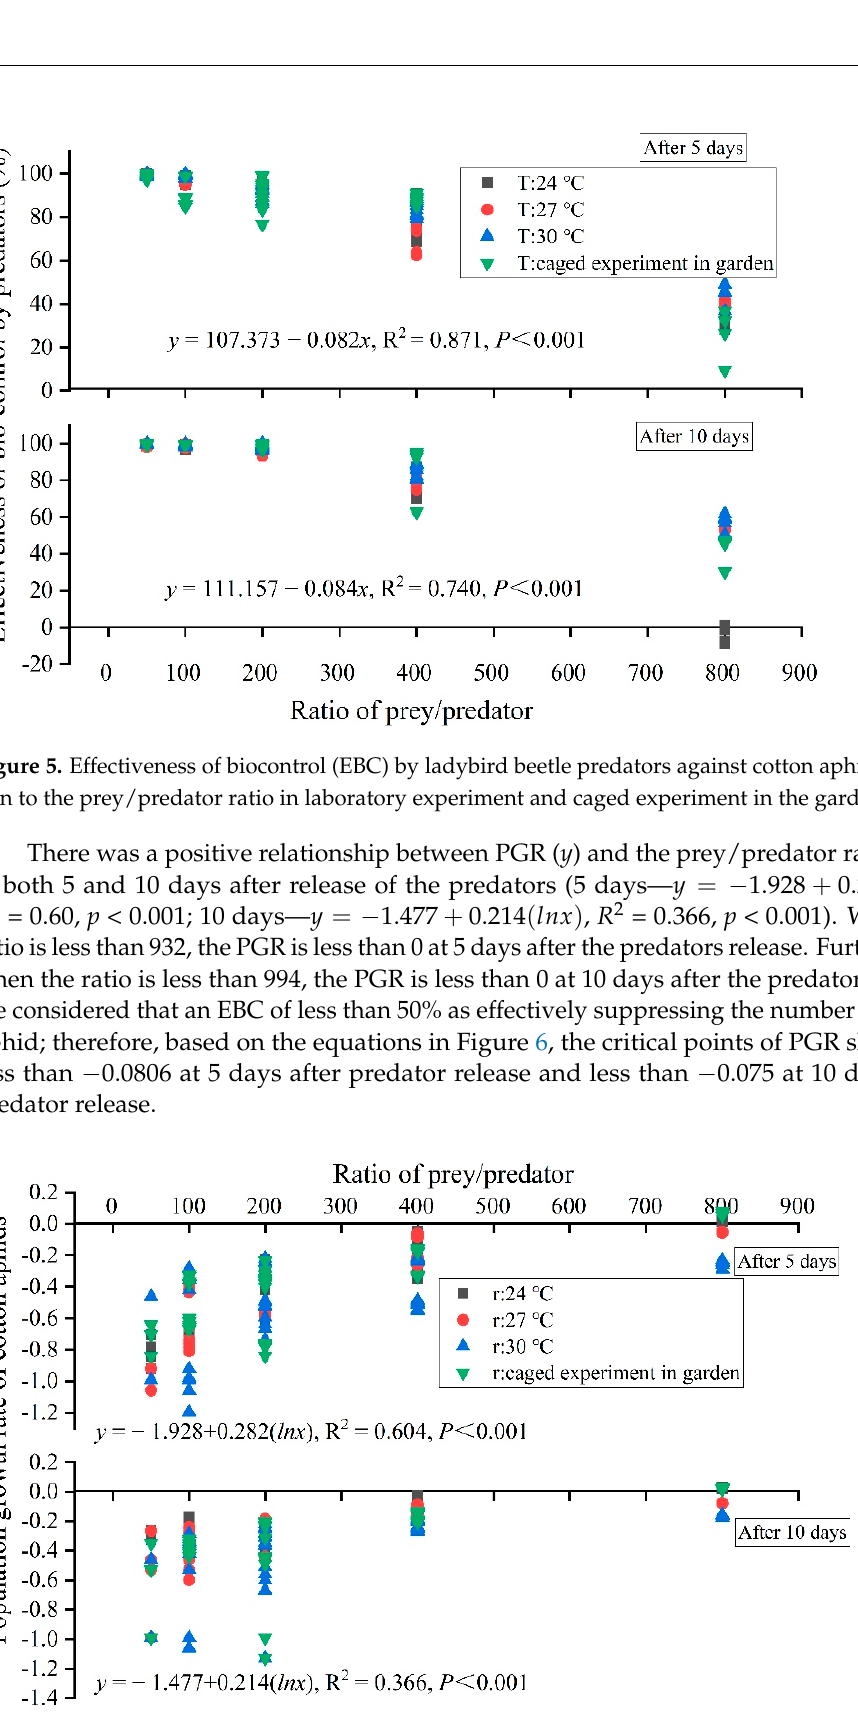
Figure 6. The relationship between the population growth rate (PGR as y ) and the prey/predator ratio (𝑙𝑛𝑥) in laboratory and open caged experiment in the garden (CEG).